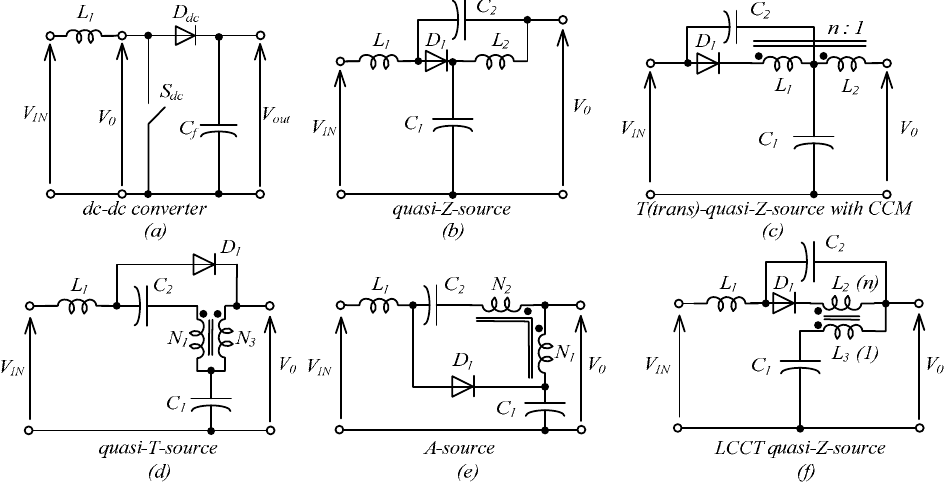
Figure 1. Basic impedance source (IS) networks along with the boost dc-dc converter: ( a ) Boost dc-dc converter, ( b ) quasi-Z-source, ( c ) trans (T)-quasi-Z-source, ( d ) quasi-T-source, ( e ) A-source, and ( f ) LCCT quasi ‐ Z ‐ source.